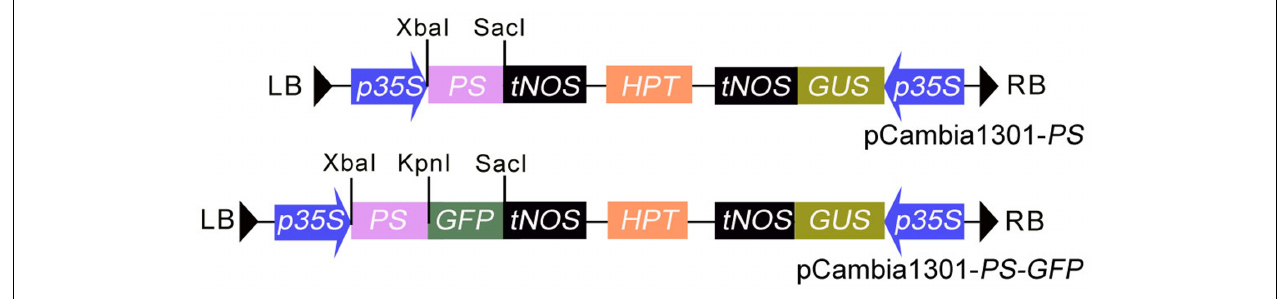
FIGURE 1 | The structure of the T-DNA region in the binary vectors of pCAMBIA1301- PS and pCAMBIA1301- PS-GFP. HPT, Hygromycin phosphotransferase gene; GUS , β -glucuronidase gene; p35S , CaMV 35S promoter; tNOS , terminator of nopaline synthase ( NOS ) gene; LB and RB: the left and right border of the